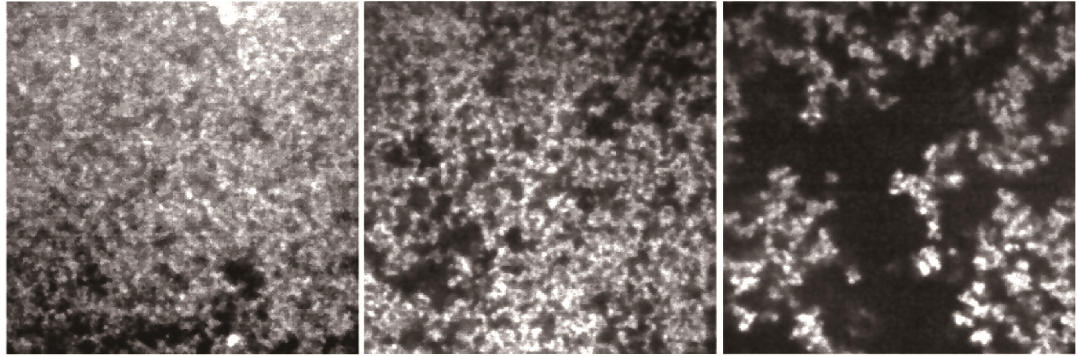
Figure 9. The CLSM images of the gels that were used in the friction measurements. The mole fraction of the cross-linker is 0.3, 0.4 and 0.5, from left to right. The image size is 30 µm × 30